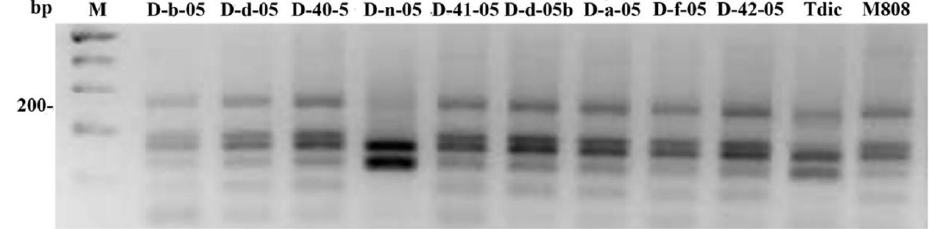
Figure 2. Genotyping of alloplasmic lines with orf256 CAPS-marker. The polymerase chain reaction (PCR) products obtained using specific primers orf256f/orf256r were digested by Taq I- endonuclease. The “100 bp” ladder was used as a length marker.